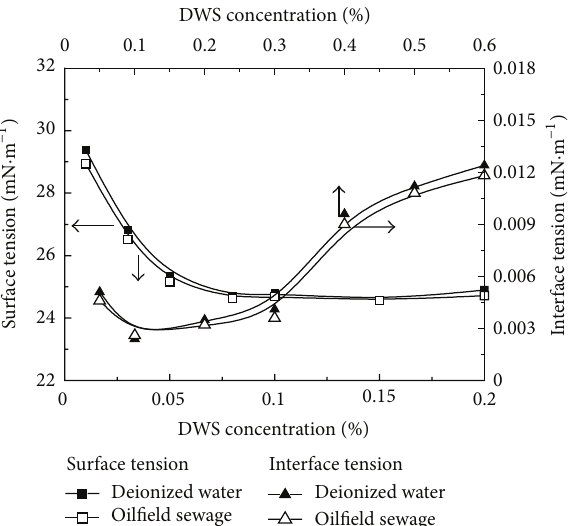
Figure 3: Viscosities of DWS in HPAM